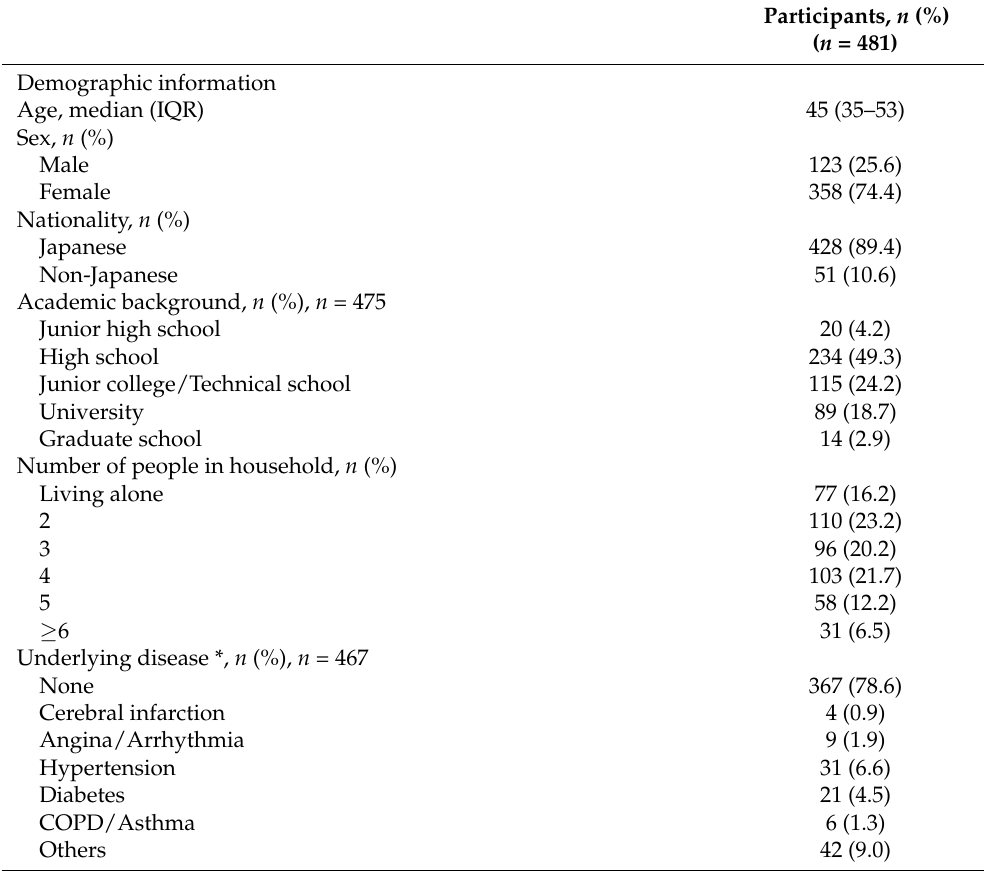
Table 1. Participants’